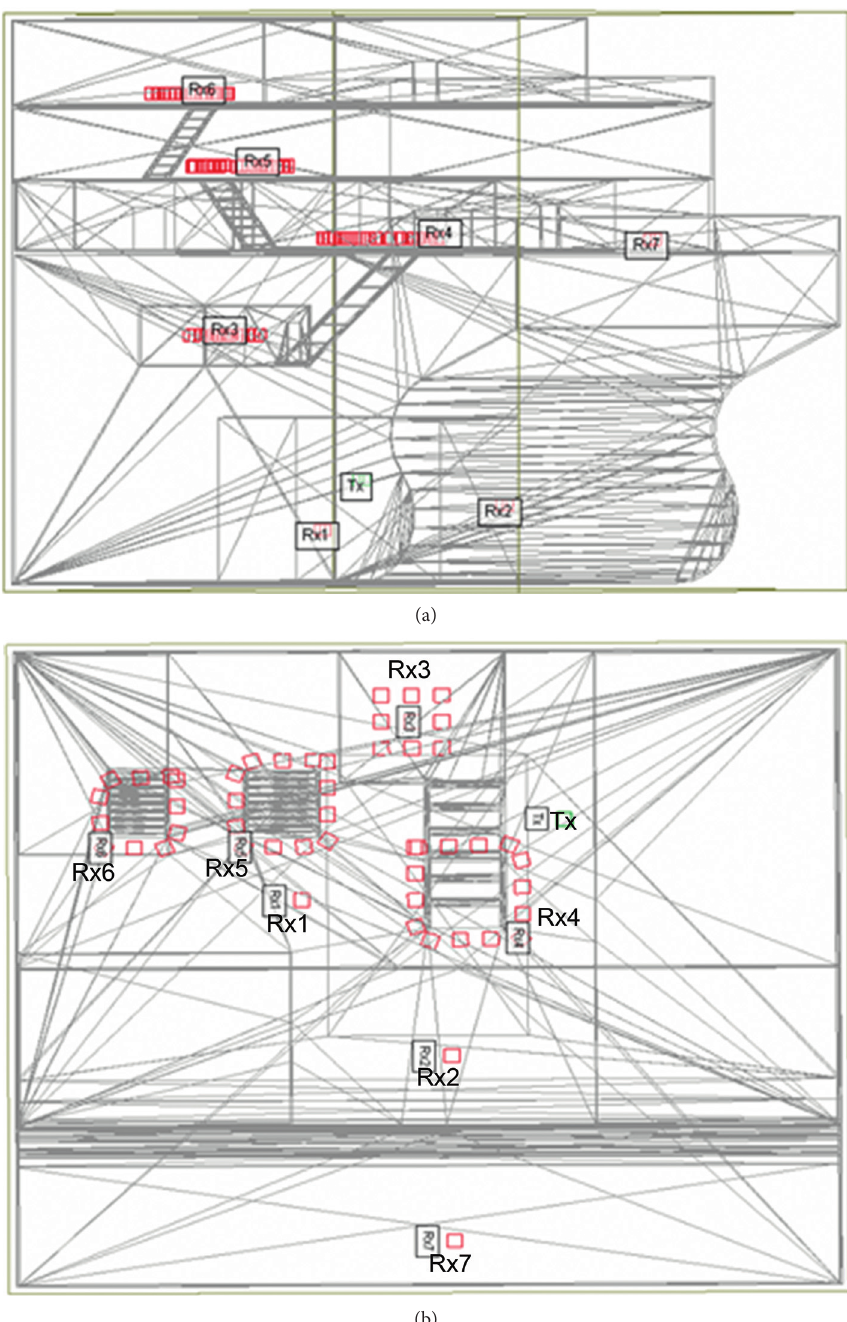
Figure 3: Deployment of the transmitter and receiver in the ship cabin. (a) The side view. (b) The vertical